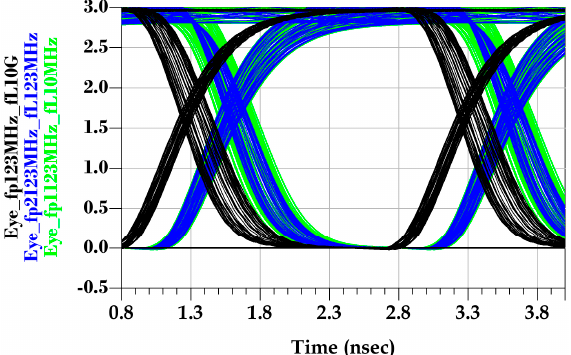
Figure 11. Output eye diagram due to distinct pre-driver and last-stage PSV variations with a L = a p = 160 mV, f P = 123 MHz, while f L = 10 GHz (black), f L = 123 MHz (blue), and f L = 10 MHz (green).